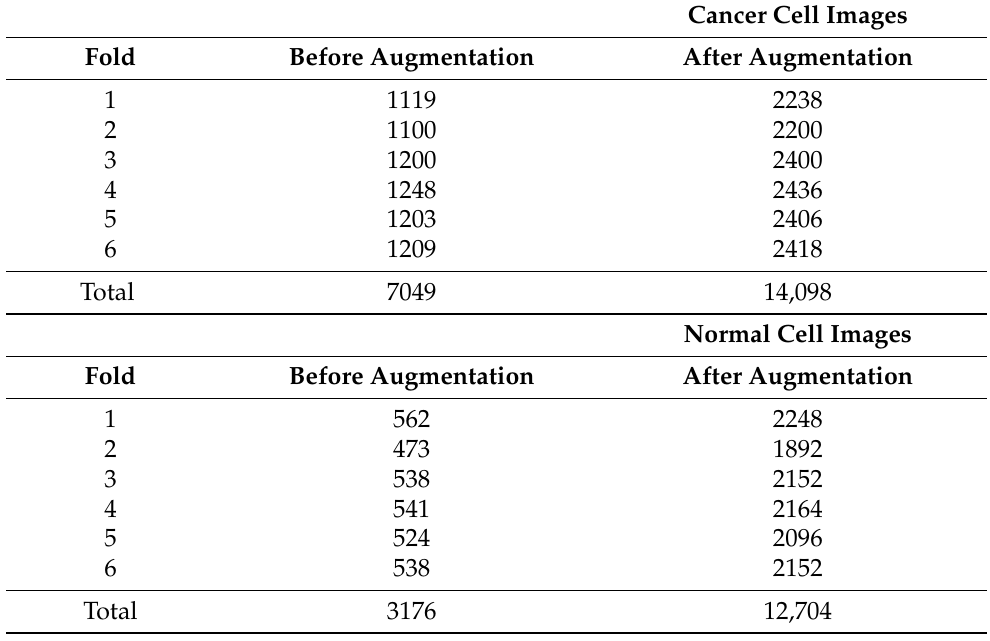
Table 2. Dataset distribution before and after data augmentation for each